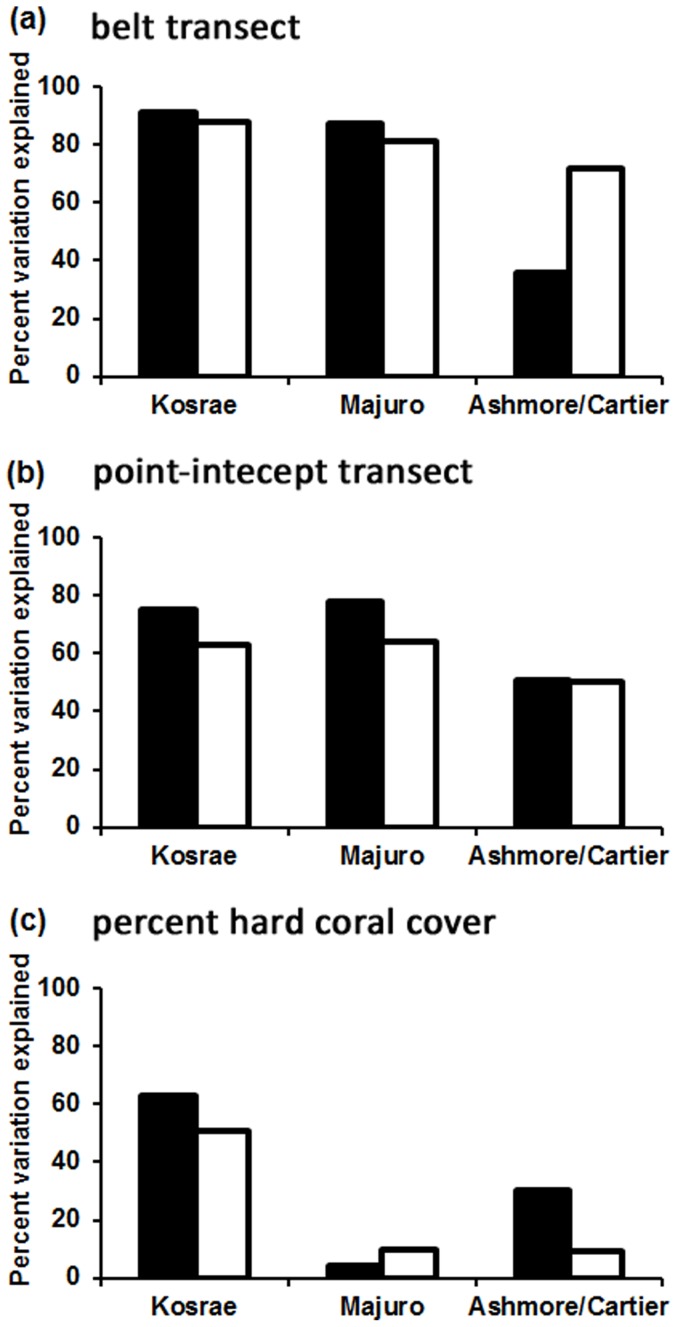
Histogram depicting the percent of variation in species richness that is explained by 3 predictor variables at 2 scales (black bars: site means; white bars: transect).(a) generic richness measured on a belt transect, (b) generic richness measured on a point-intercept transect, (c) percent live hard coral cover measured on a point-intercept transect.